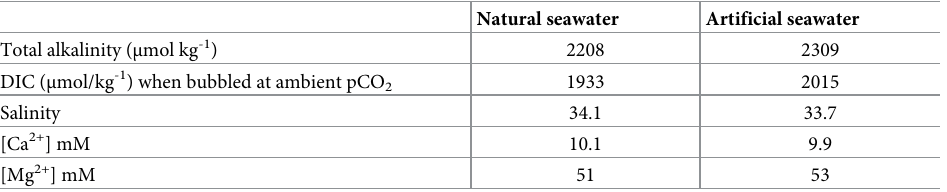
Table 1. Chemistry of the waters used for precipitations. [Ca 2+ ] and [Mg 2+ ] is estimated for artificial seawater (based upon composition) and measured (by ICP-OES) for natural